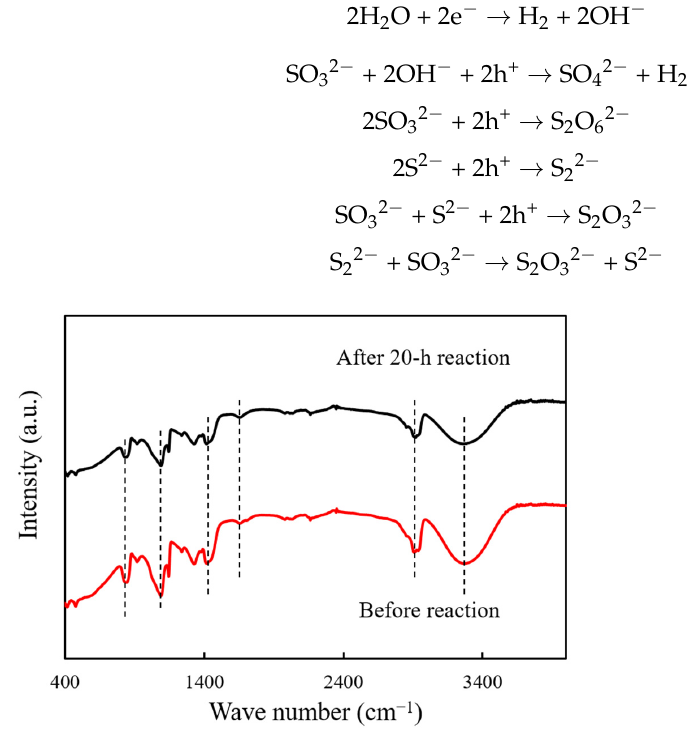
Figure 6. FTIR spectra of PVA-ZnOS200 before and after 20 h photoreaction.